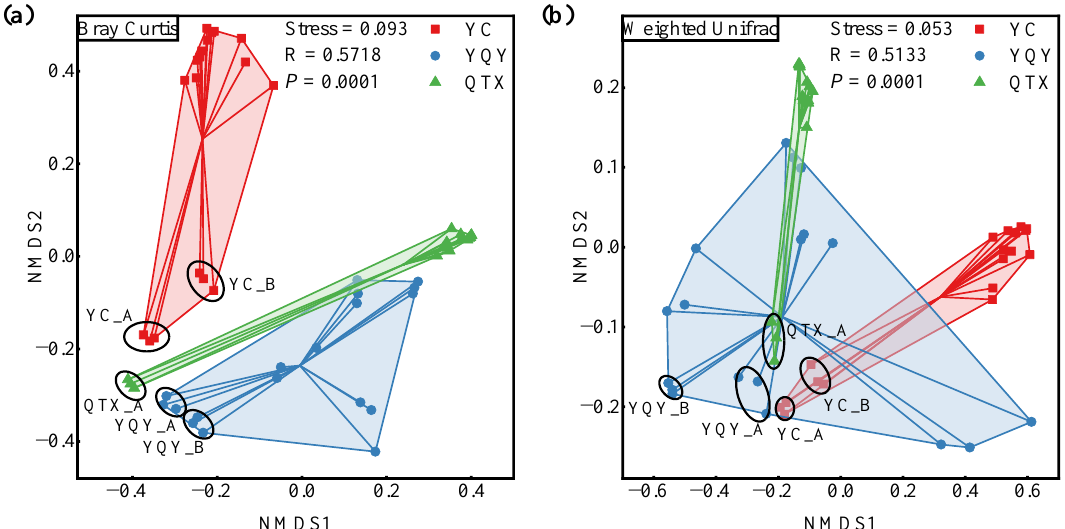
Figure 2. NMDS plots of samples from different sub-regions. Discrimination by ( a ) taxonomic distance, and ( b ) phylogenetic distance. The NMDS stress value below 0.1 and simultaneously p -value below 0.05 indicate significant discrimination among different sub-regions. The color of each square/dot/triangle corresponds to the color of each sub-region in the legend.